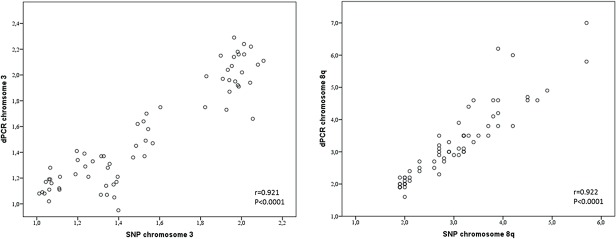
Correlation between dPCR and SNP with regard to chromosome 3 and 8q copy numbers.Copy numbers of chromosome 3 and 8q in UM calculated with SNP and dPCR display a strong correlation (r = 0.921 and r = 0.922, p<0.0001), indicating that these methods cross validate each other.